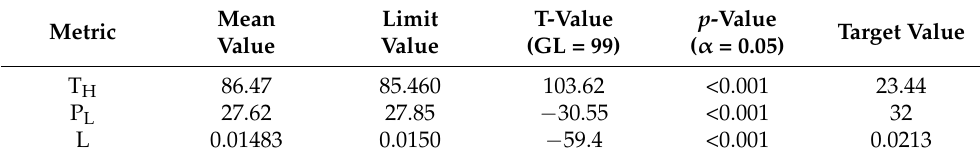
Table 7. Statistical analysis of QCCP performance, with a simulation window of 800